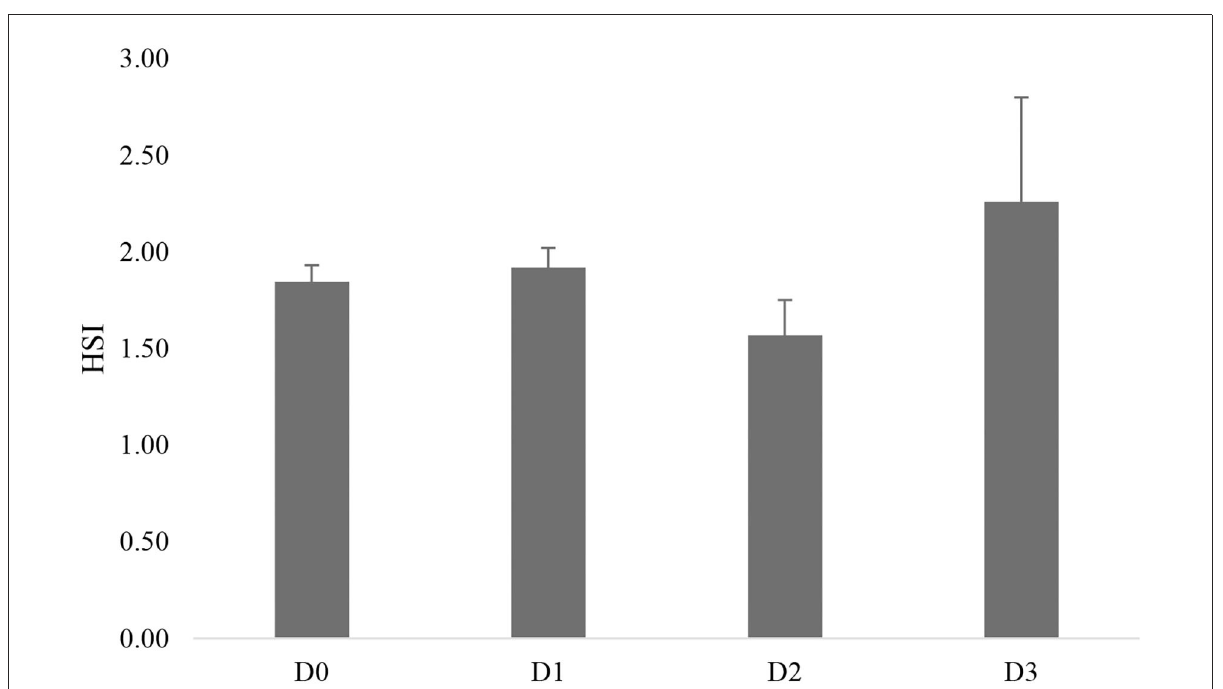
FIGURE5 Hepatosomatic index (HSI) of seawater-tolerant tilapia fed with different levels of T. weissflogii